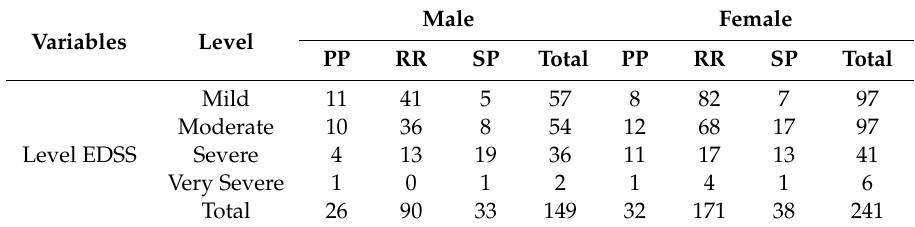
Table 2. Sample level disability by gender and the type of multiple sclerosis.